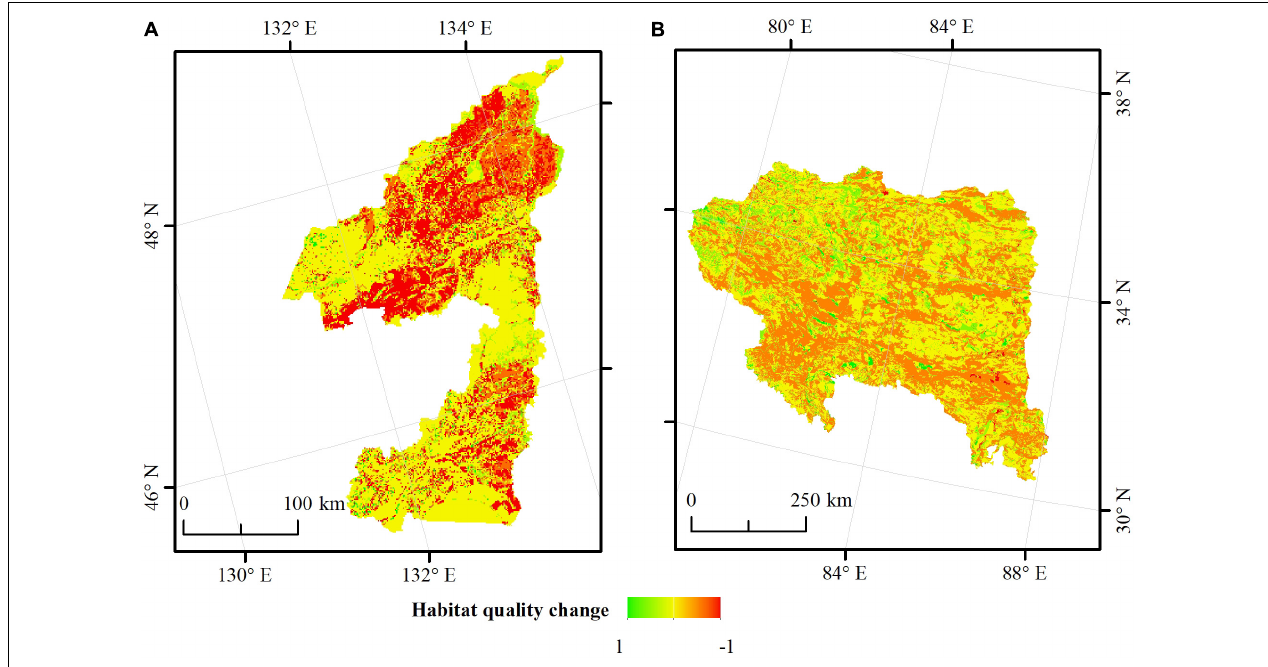
FIGURE 6 | Spatial distribution of habitat quality changes in SJPW (A) and NTQTP (B) from 1980–2018.